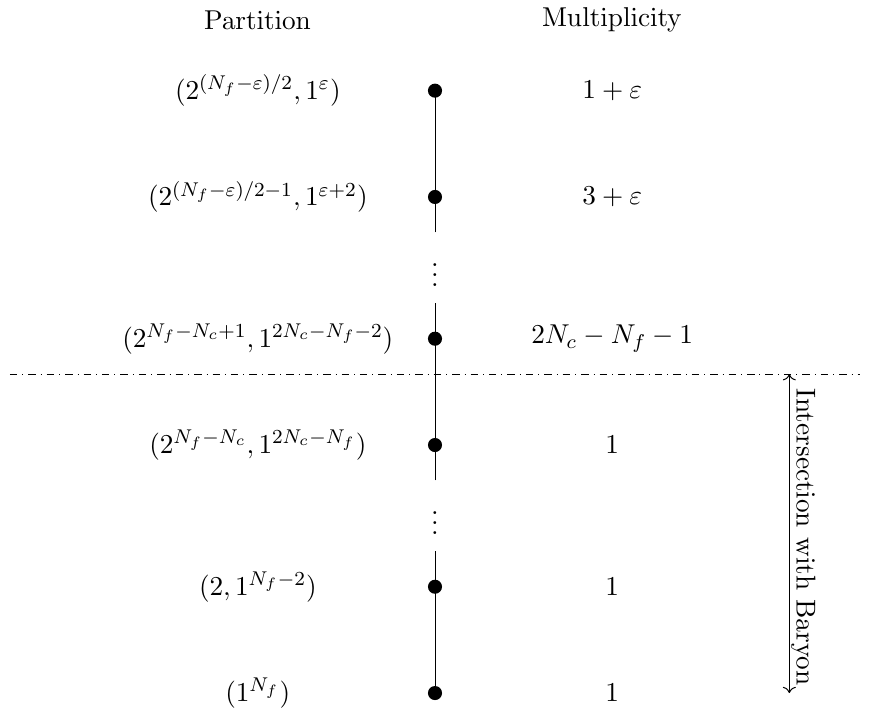
Figure 23 . The height two part of the Hasse diagram of sl ( N f , C ), with the conjectured associated orbit multiplicities of the mesonic branch in the presence of a baryonic branch. ε = 0 if N f is even and ε = 1 if N f is